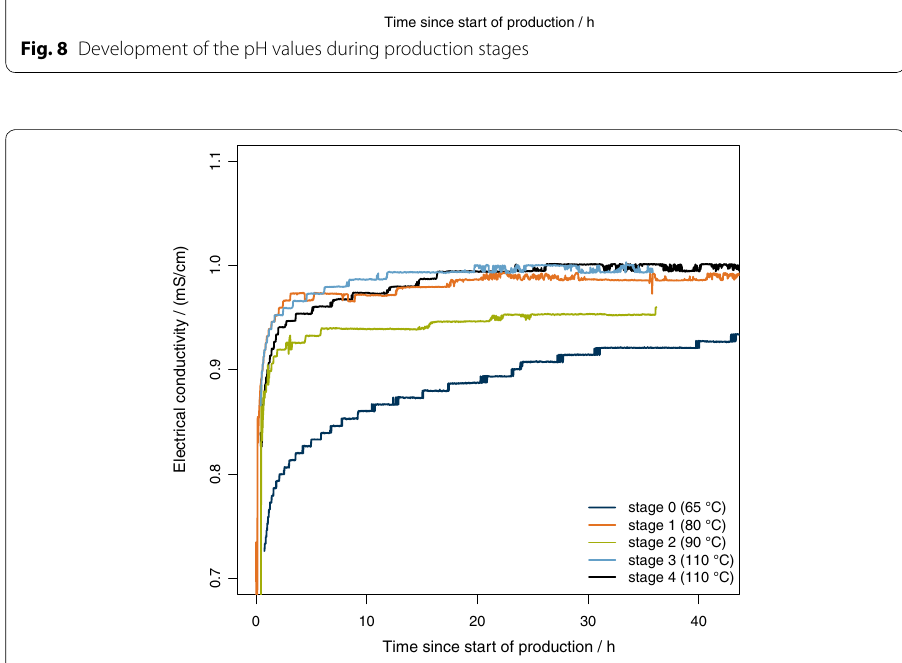
Fig. 9 Development of the electrical conductivity during production